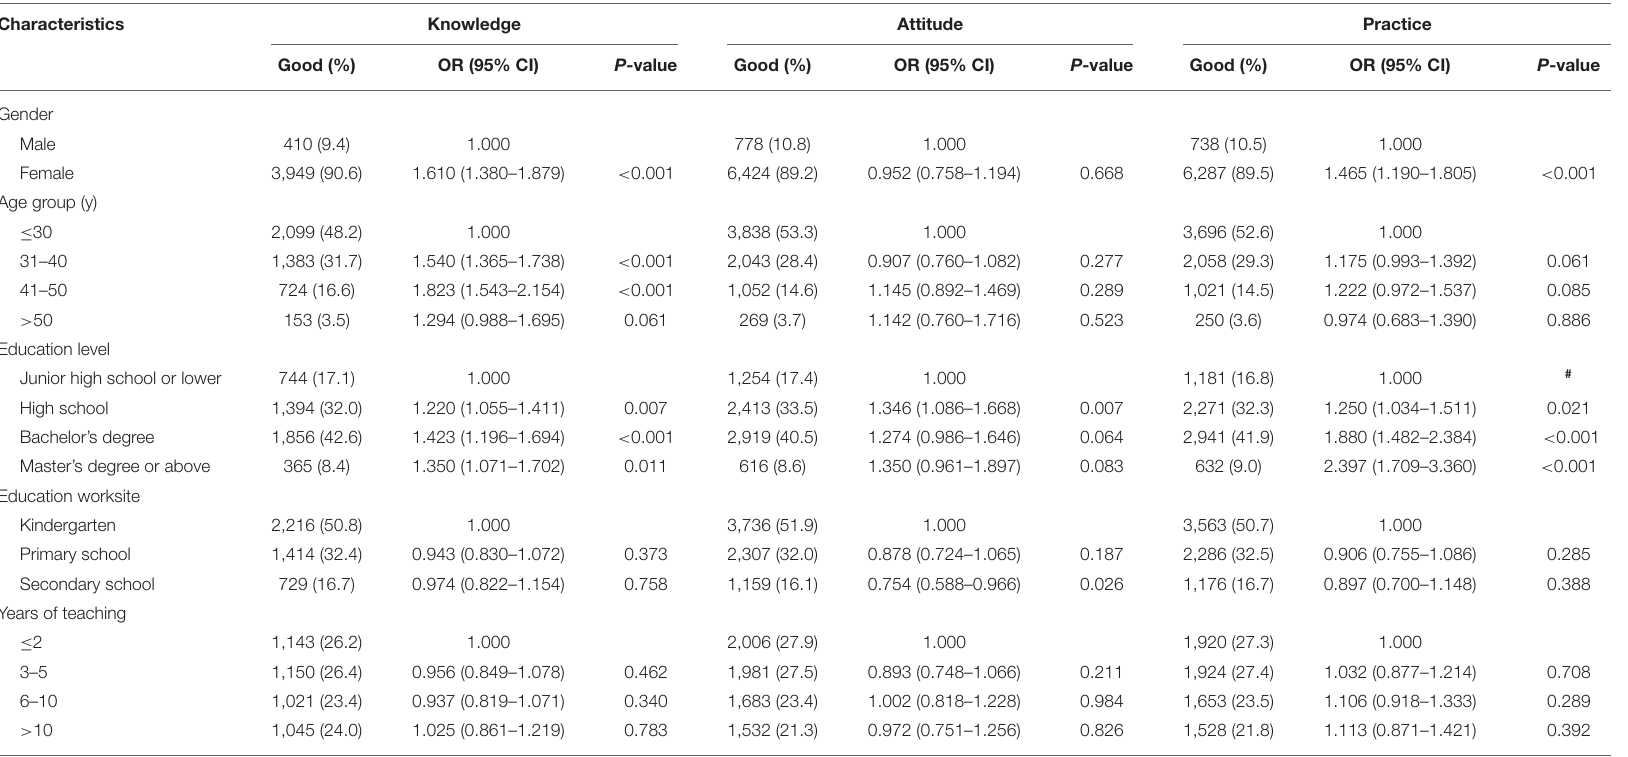
TABLE 3 | Factors associated with good knowledge, attitudes, and practices toward COVID-19 among the teacher population.